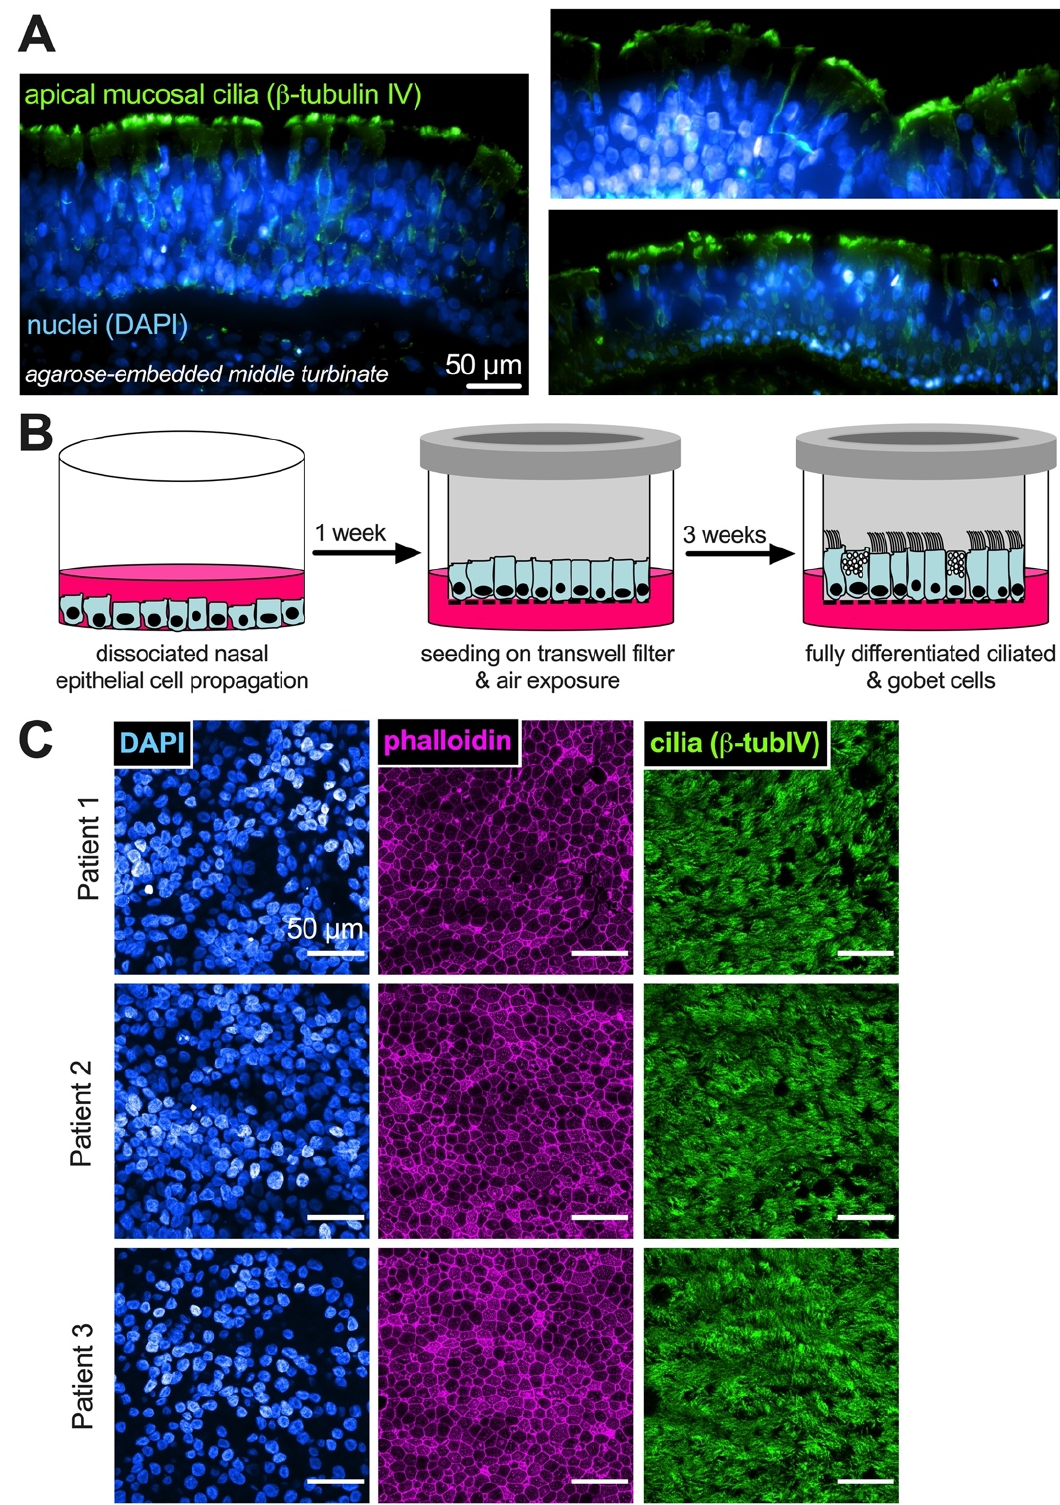
Figure 1. Generation of air–liquid interface (ALI) cultures from residual surgical material. ( A ) Nasal turbinate mucosal tissue was removed from the bone, embedded in agarose, sliced and fixed. Immunofluorescence staining for β -tubulin IV (green) shows the highly ciliated mucosal surface. Nuclei are shown in blue. Representative tissue slices from three patients are shown. Spinning disk confocal, 10 × 0.4 NA objective. Scale bar is 50 µm. ( B ) non-fixed or embedded tissue is enzymatically dissociated and basal epithelial cells are propagated in submersion culture. Cells are seeded onto permeable Transwell filters at high density, and the next day, the medium on the apical surface is removed. The resulting air exposure on the apical side leads to the differentiation of cells into cili- ated and goblet cells reminiscent of the in vivo epithelium; ( C ) representative immunofluorescence